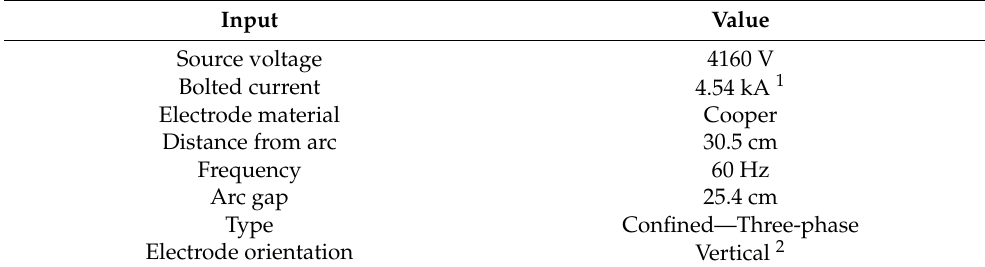
Figure 9. Data input screen for ArcPro simulation—Case study 3. Table 6. Relation of input data for ArcPro simulation—Case study 3.